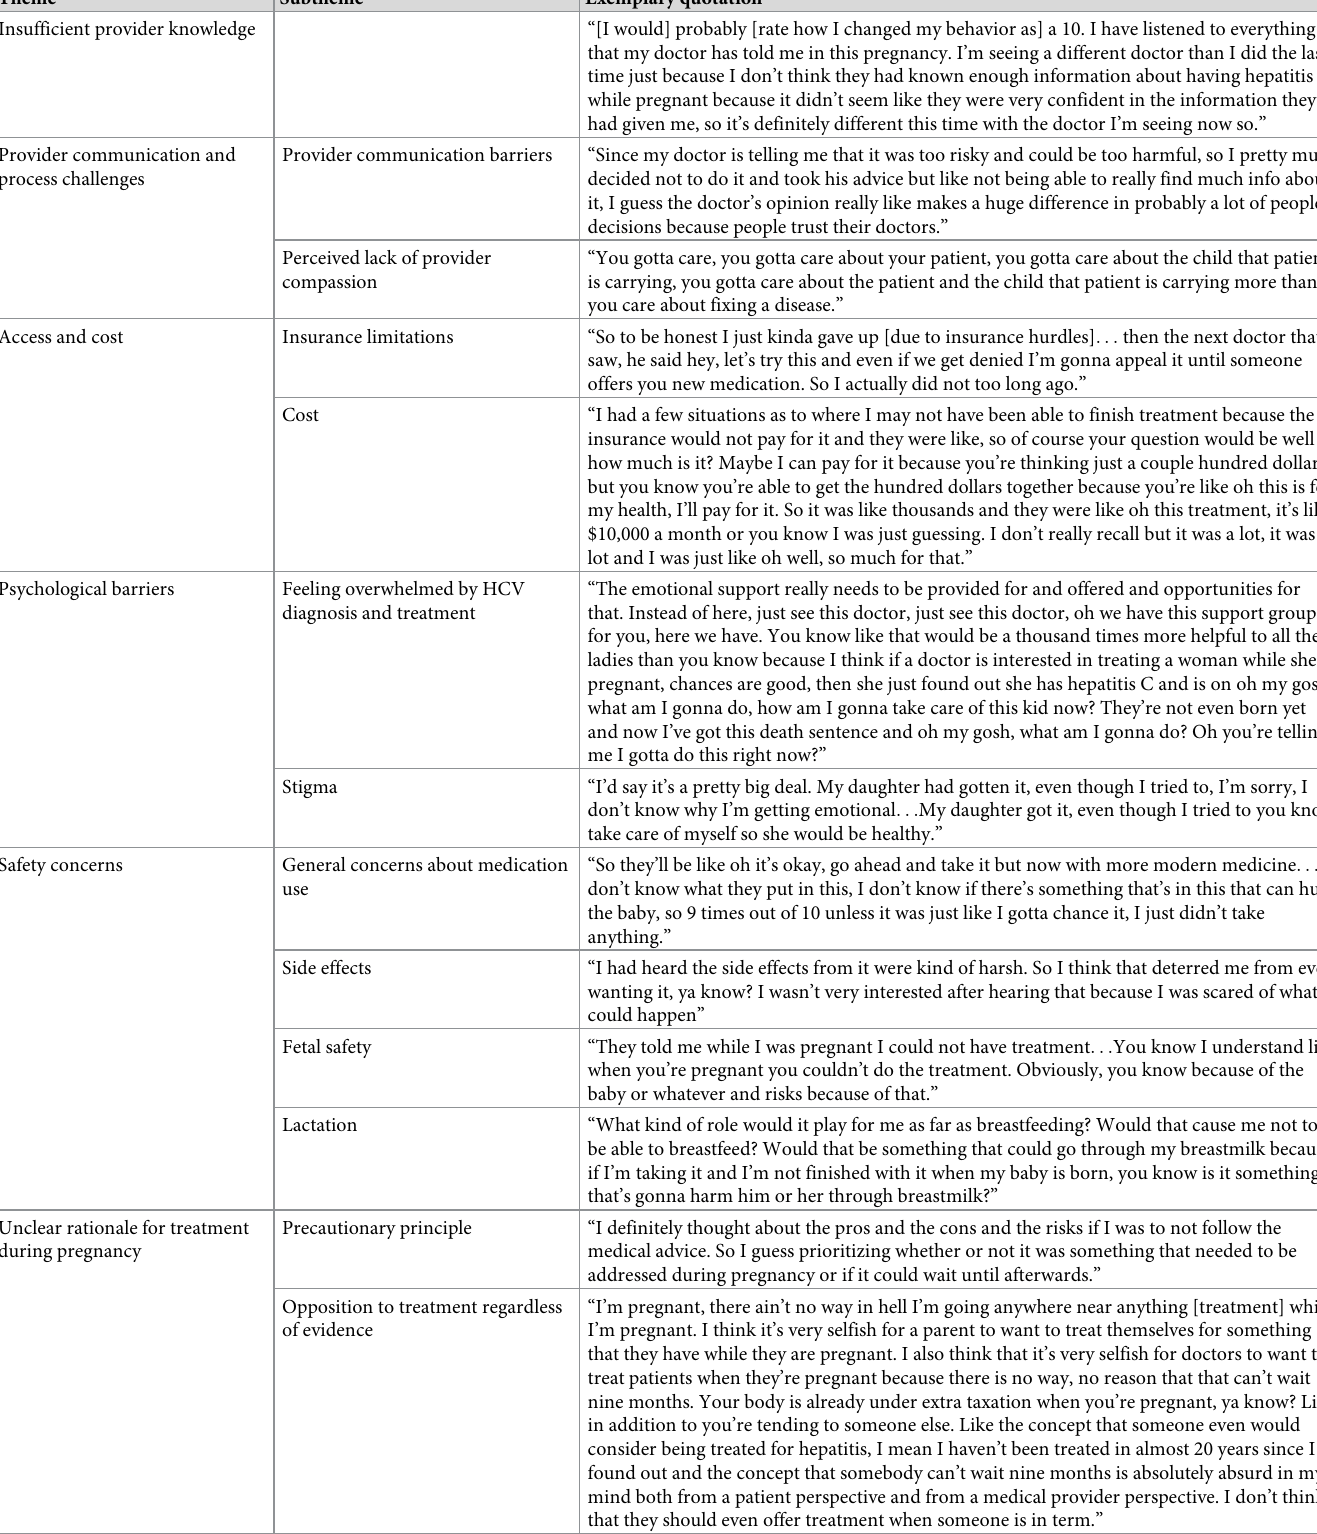
Table 3. Patient perceptions of barriers to treatment of HCV during